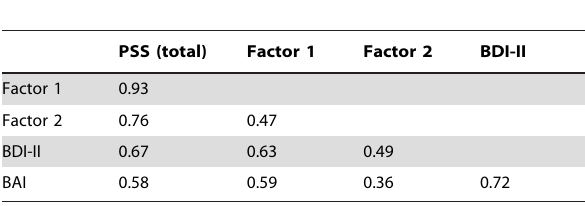
Table 2. Correlations of PSS-10 to depression (BDI-II) and anxiety